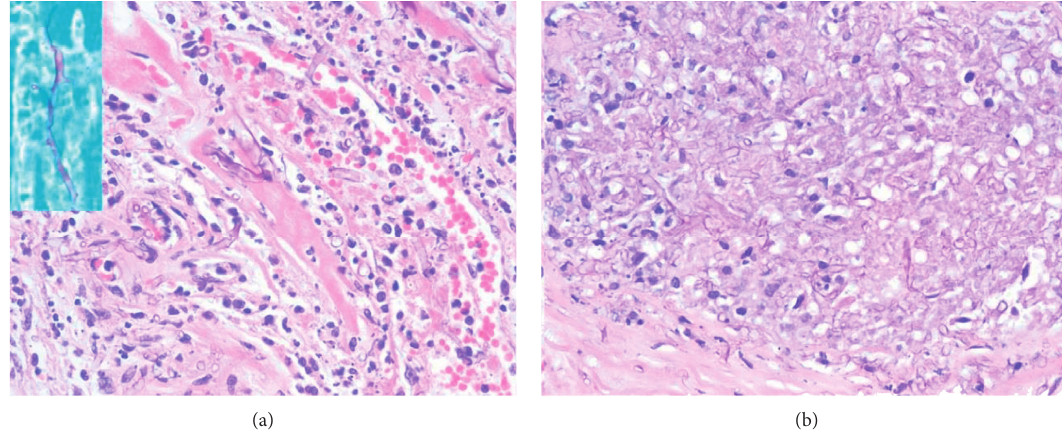
Figure 5: Autopsy: heart and kidneys. Cardiac (a) and renal (b) mucormycosis, H&E and GMS (small panel) stains.